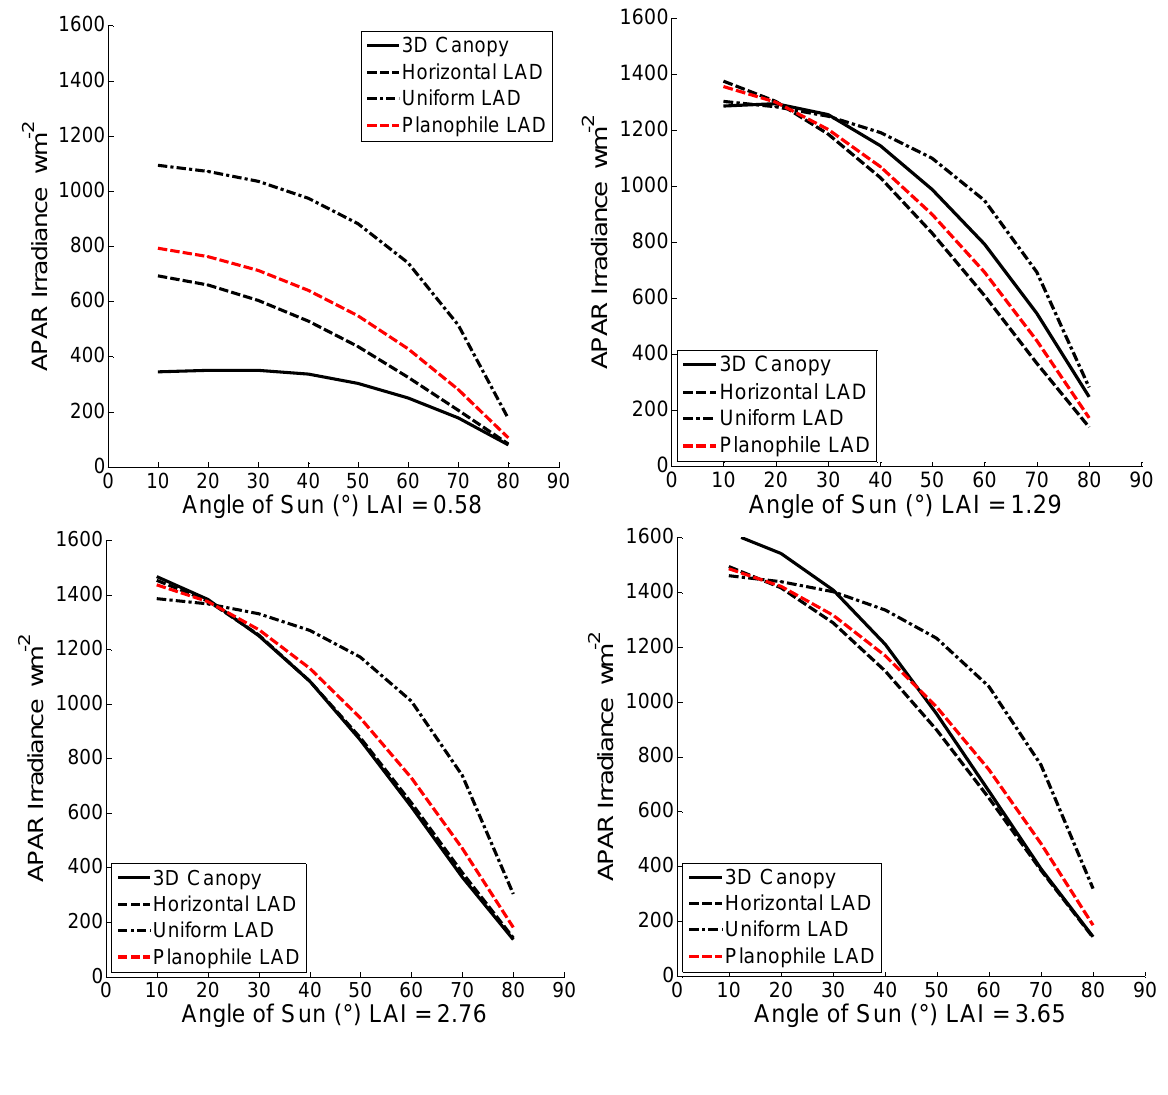
Figure 5. Diurnal sun angular variation of canopy APAR (w m − 2 ). The four different graphs show absorbed irradiance from all canopy representations and